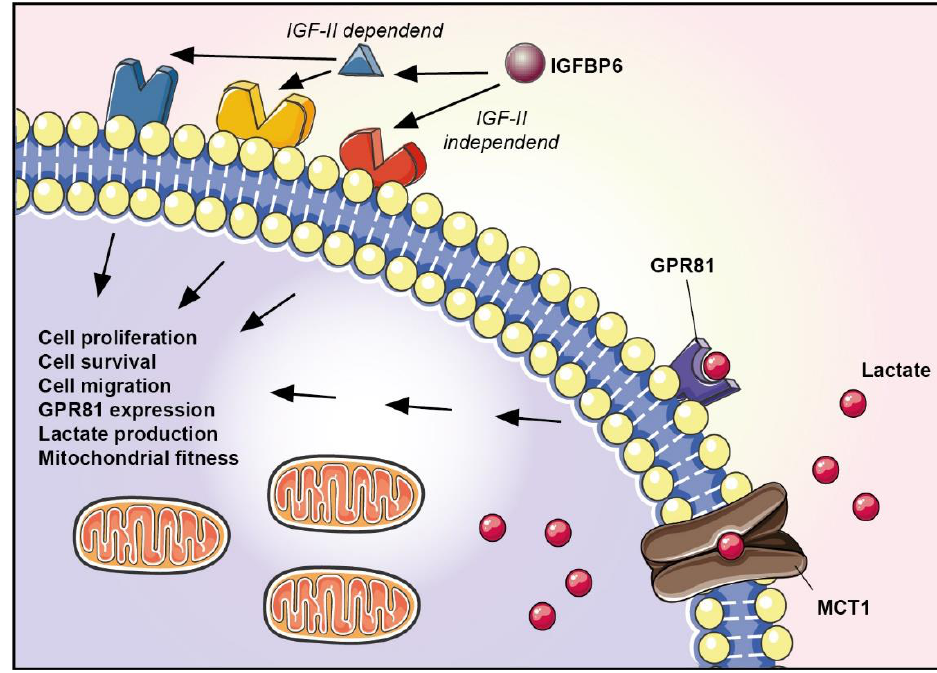
Figure 6. Graphical representation of GPR81 and IGFBP6 axis.